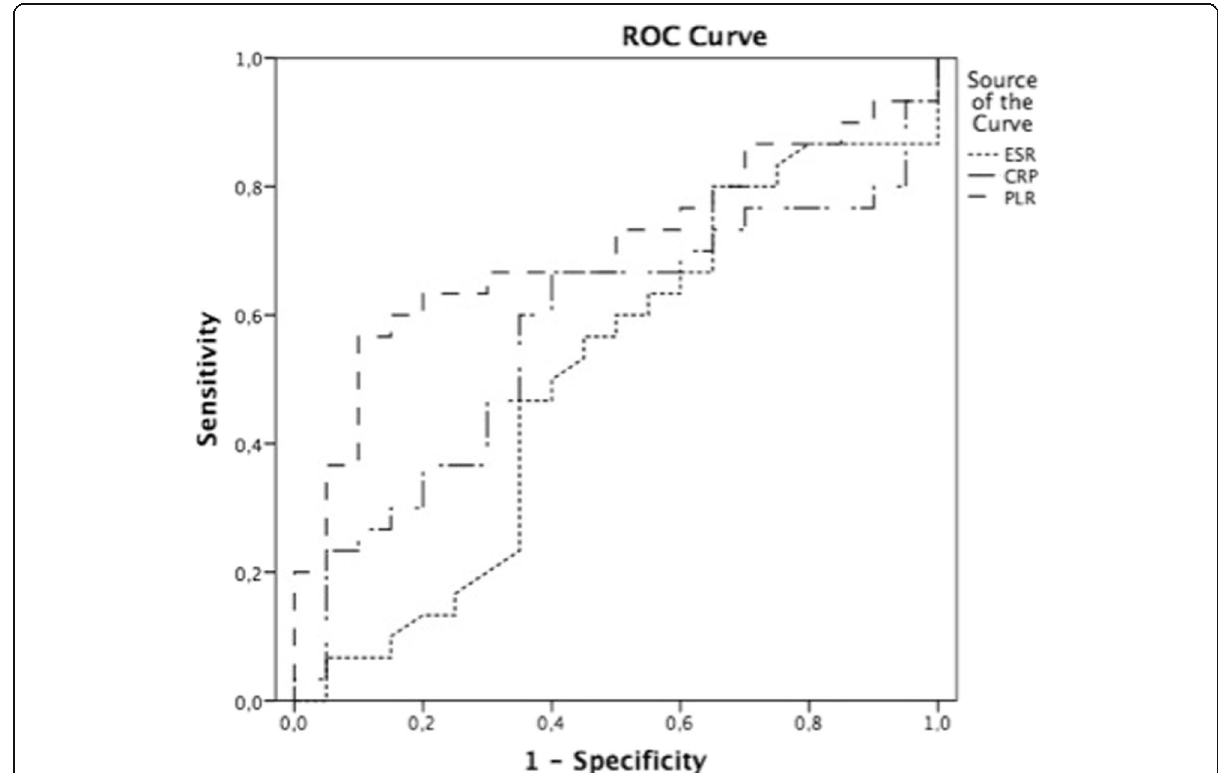
Fig. 1 Receiver operating characteristic curve of PLR, ESR and CRP for differentiating renal